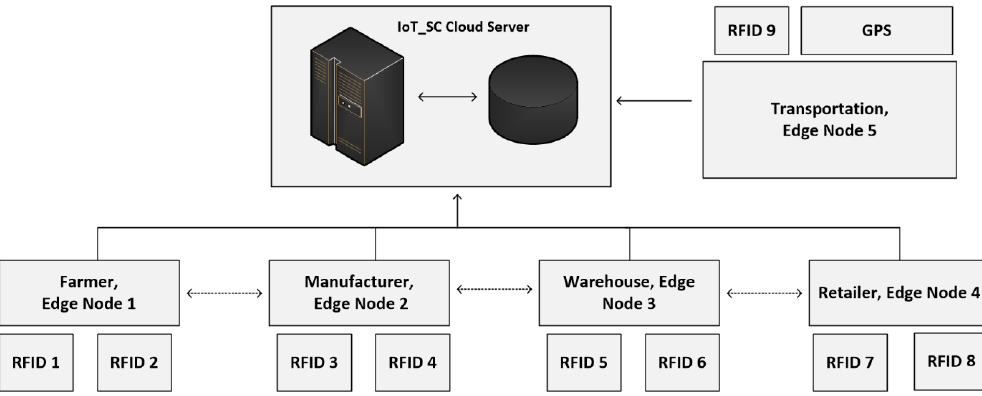
Figure 4. A setup and nodes connectivity of the IoT-SC system: each edge node is responsible to carry specific operations through its connected nodes, operations are a number of transactions written to IoT-SC controller: edge nodes are only authorized to write transactions to IoT-SC controller. To provide an end-to-end supply chain, each edge node performs the desire operations time-to-time and writes as transactions to the IoT-SC controller.